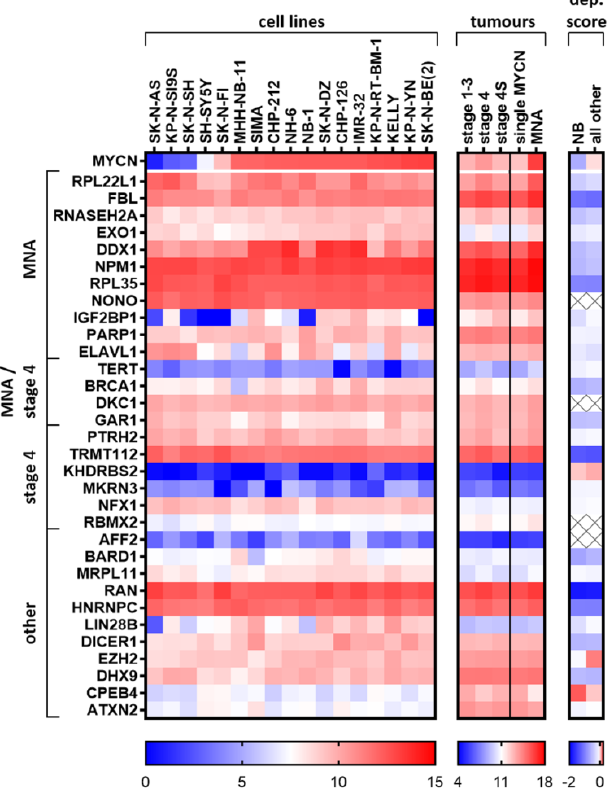
Figure 4. Expression of candidate oncogenic RBPs in neuroblastoma cell lines and in tumour groupings. Broad Institute Cancer Cell Line Encyclopedia (CCLE) neuroblastoma cell lines